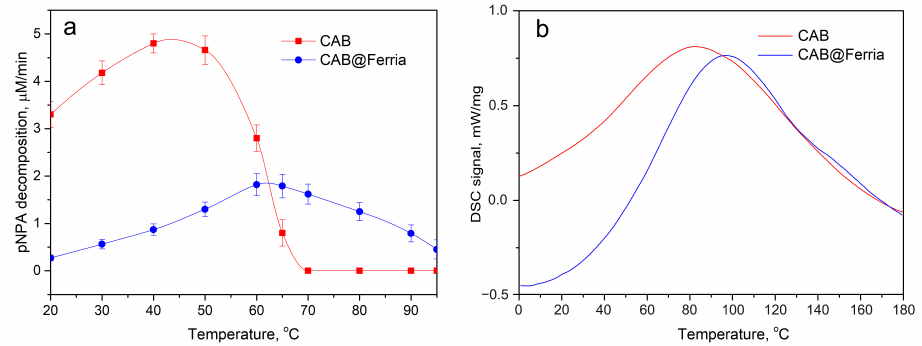
Figure 2. Thermal behaviour of free CAB and CAB@Ferria: ( a ) Catalytic activity of free CAB and CAB@Ferria as a function of temperature. The points represents average of three